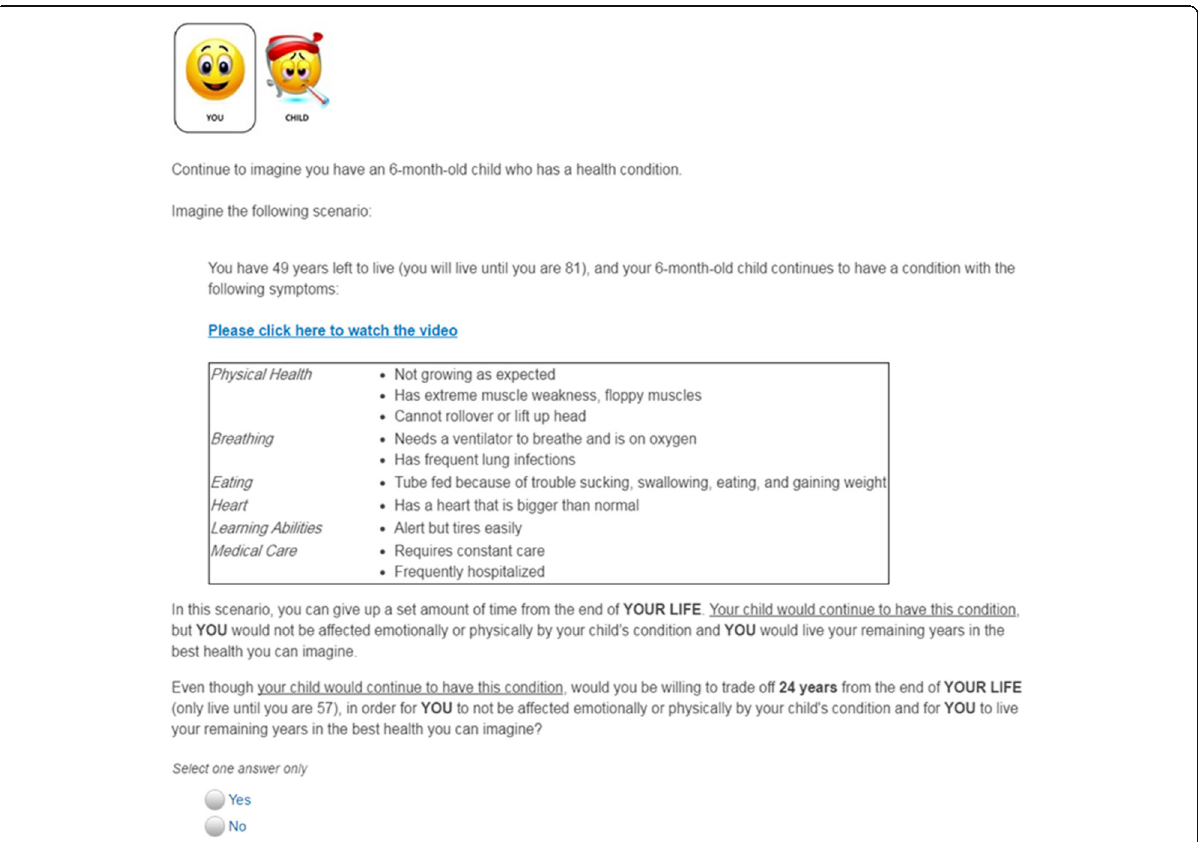
Fig. 3 Sample of a Time Trade-Off